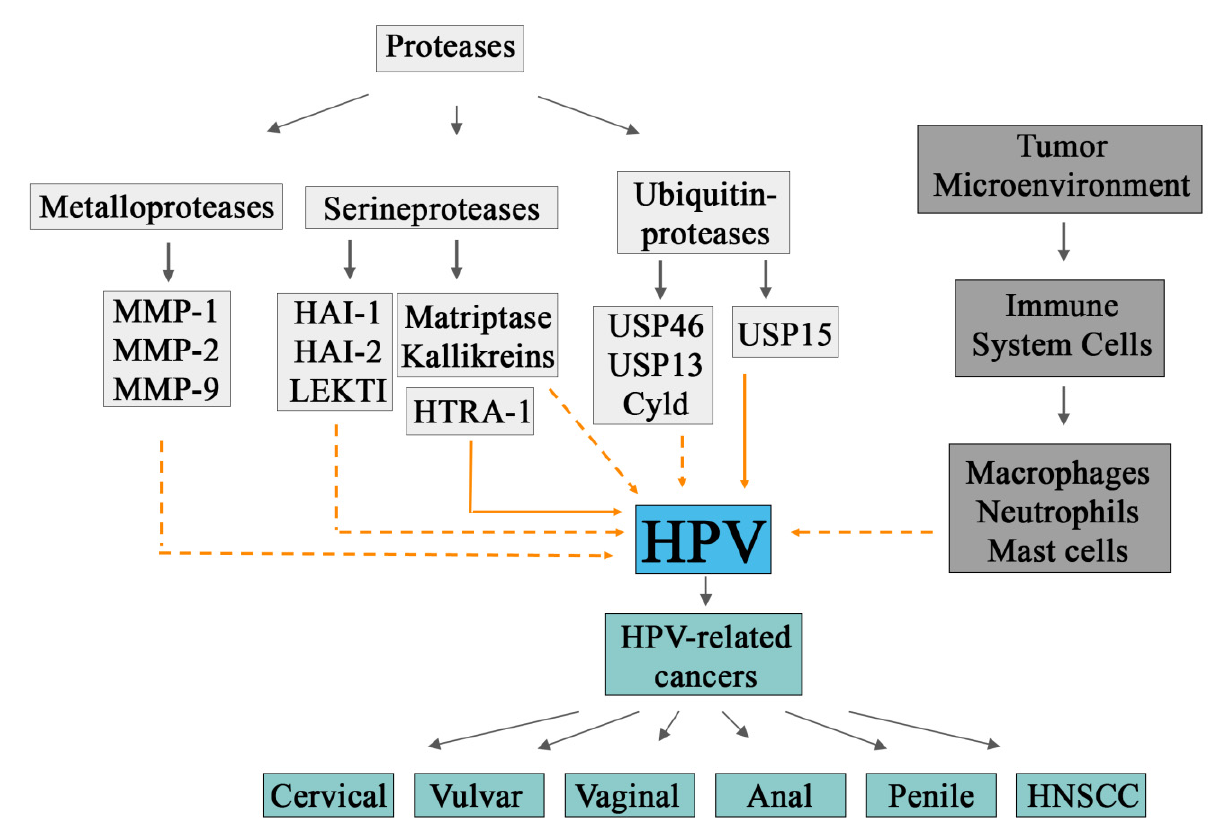
Figure 2 sums up the interactions that might occur between proteases, the tumor microenvironment, and HPV.